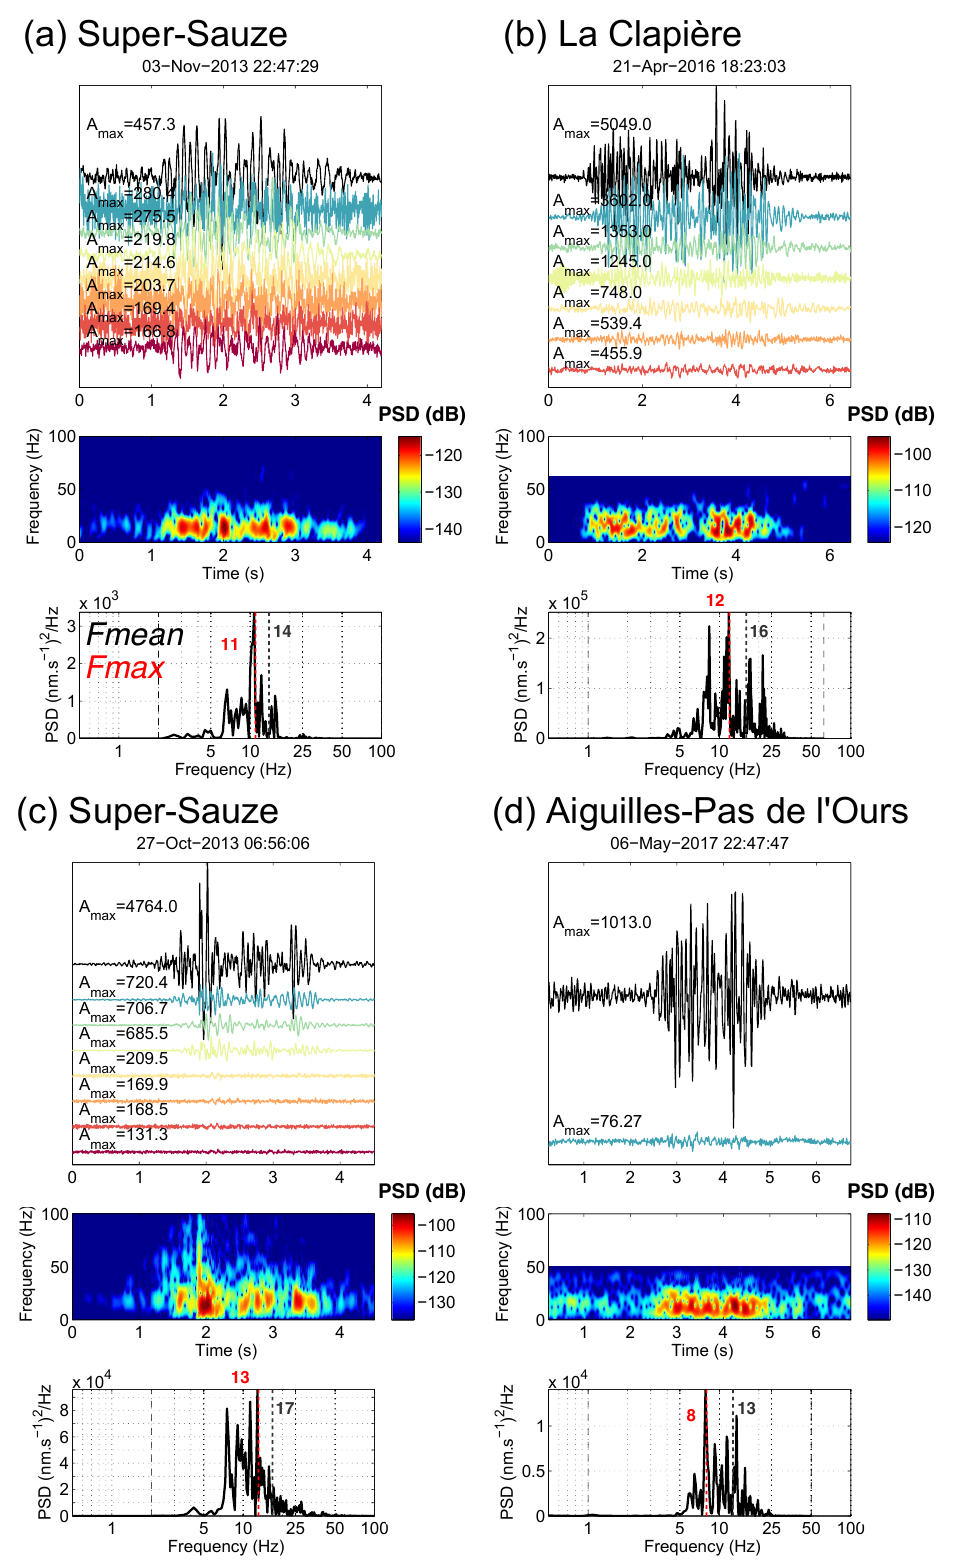
Figure 10. Examples of tremor-like slopequakes recorded at the (a, c) Super-Sauze, (b) La Clapière and (d) Aiguilles-Pas de l’Ours slopes. See Fig. 2 for a description of the